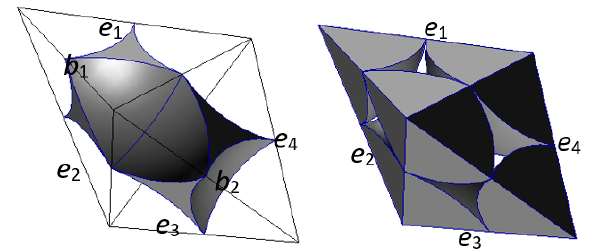
Figure 4. The void part ( left ) and solid part ( right ) in the void cell system. ( e , b are the edge and the body in the void cell system,